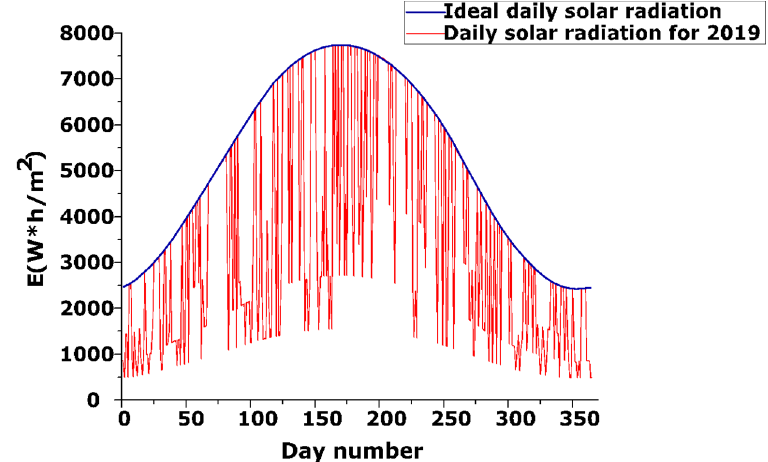
Figure 13. Calculated annual solar radiation under ideal conditions and taking into account weather conditions.